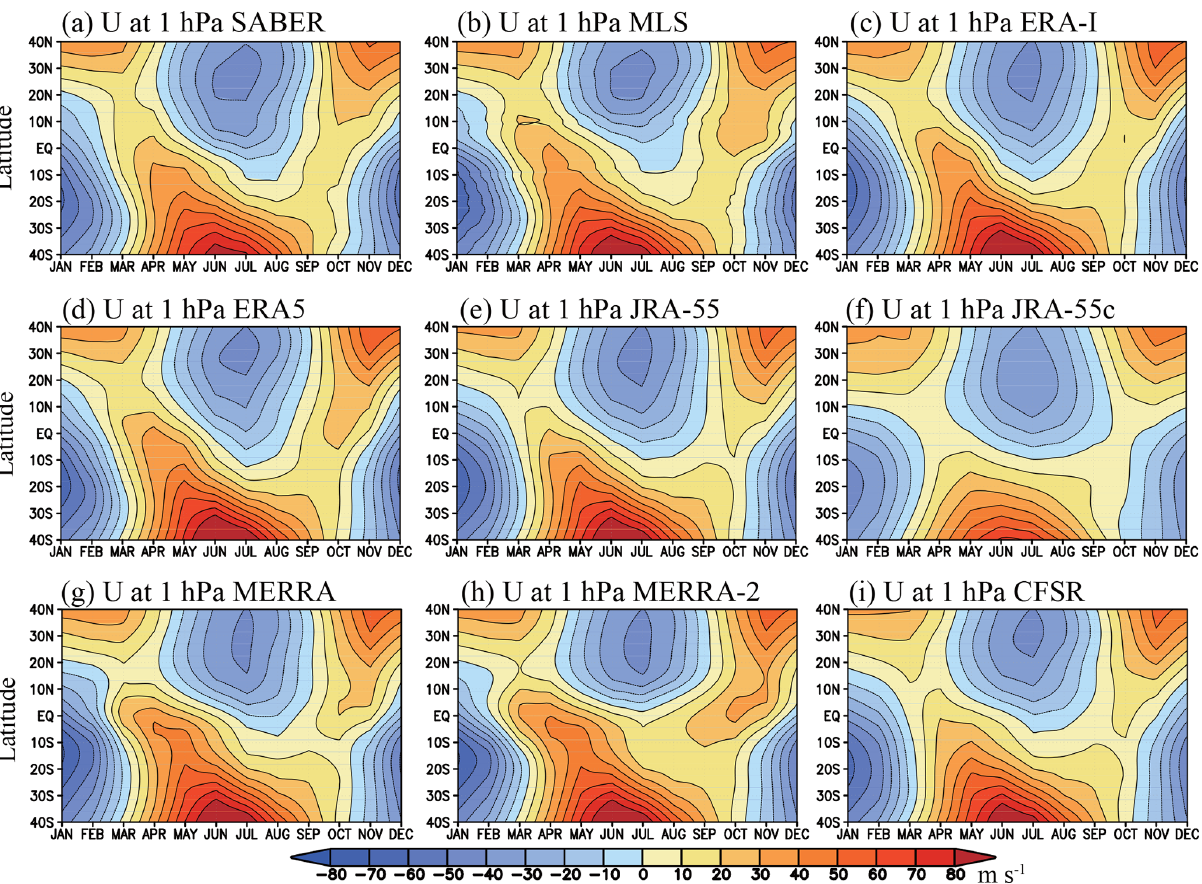
Figure 8. Time–latitude sections of climatological mean annual cycle of the zonal mean zonal wind for (a) SABER, (b) MLS, and (c–i) each reanalysis at 1hPa. The contour intervals are 10ms − 1 . Climatology is calculated from 1980 to 2010 in the reanalyses, from 2002 to 2016 in SABER, and from 2005 to 2016 in